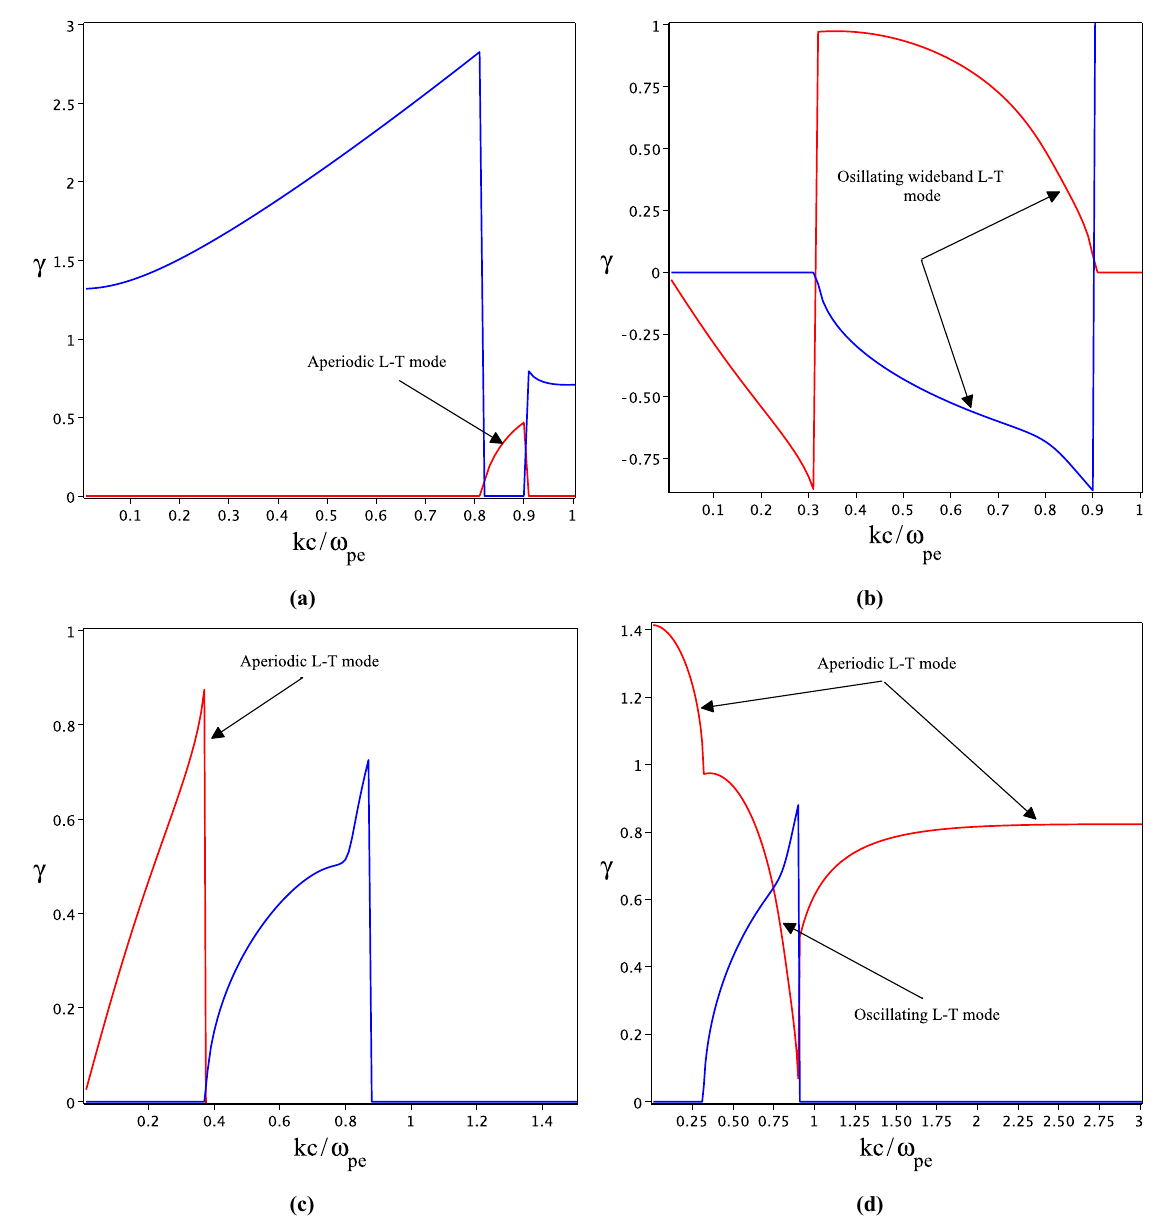
Figure 3. The spectrum of Longitudinal-Transverse instability in strongly coupled limit for a 0 = 2 . The blue line indicates the real parts of mode frequency γ = Re ¯ ω and the red line shows instability growth rate γ = Im ¯ ω . ( a , c ) The aperiodic and ( d ) shows oscillating modes. ( d ) Contains both oscillating and aperiodic modes at different frequencies